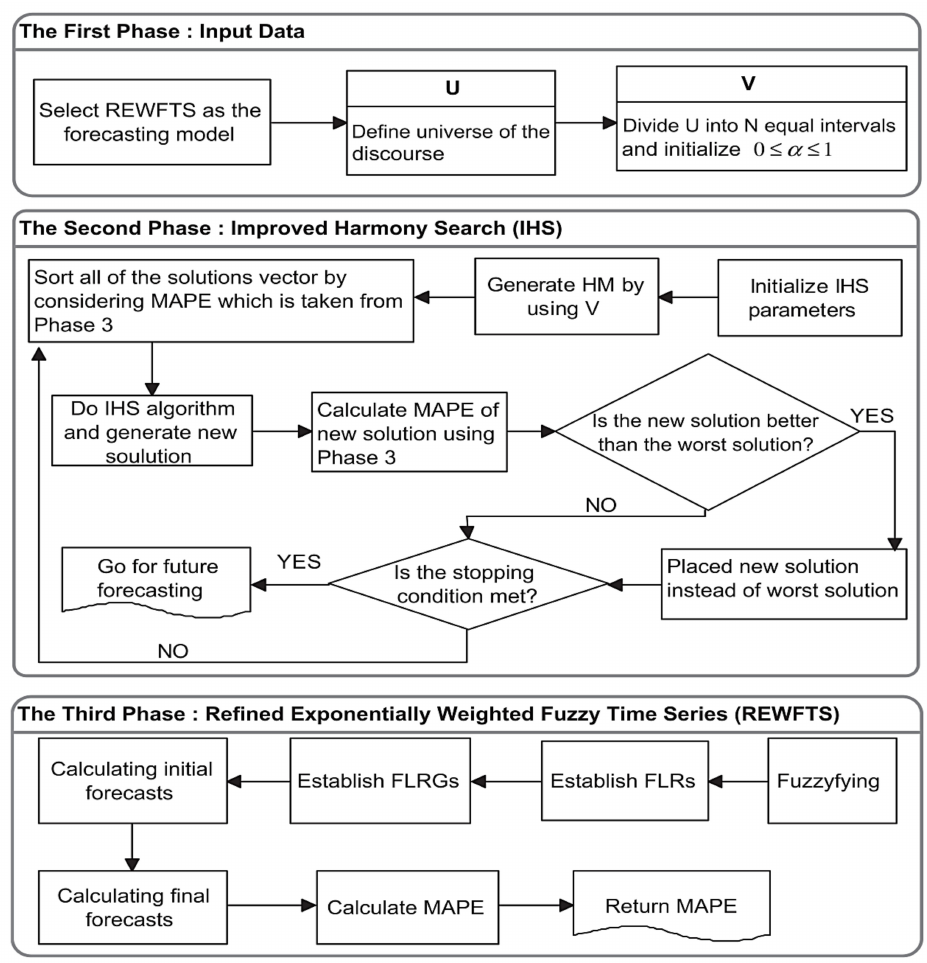
Figure 5. REWFTS–IHS algorithm